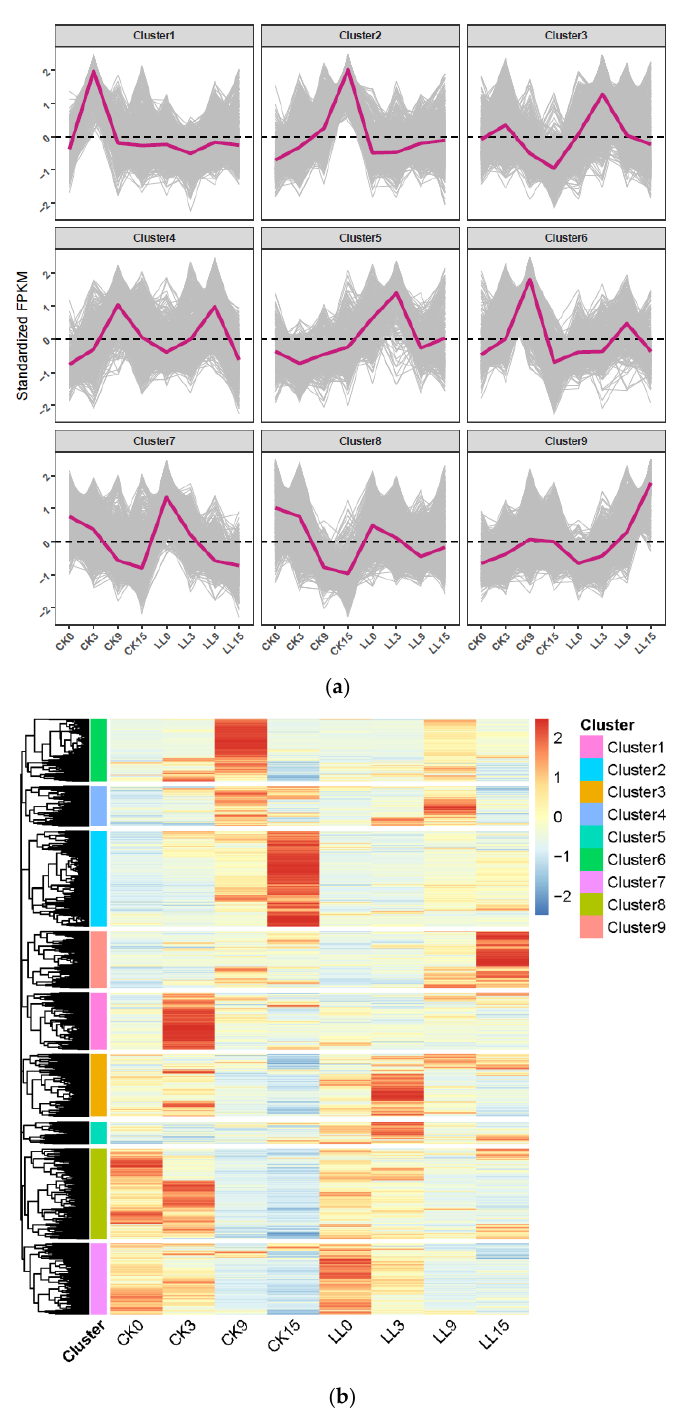
Figure 3. Clustering analysis of 8837 DEGs between CK and LL. ( a ). Hierarchical clustering of 8837 DEGs. ( b ). Expression patterns of the 8837 DEGs in the nine clusters.